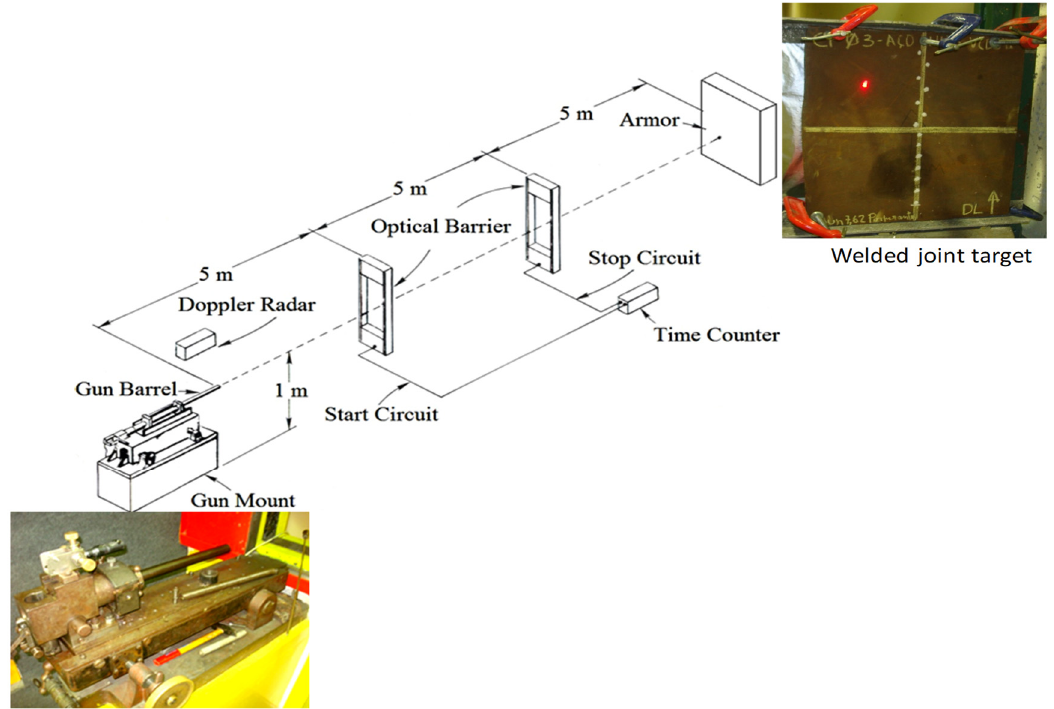
Figure 4. Schematic of ballistic test with actual gun barrel and welded joint target.